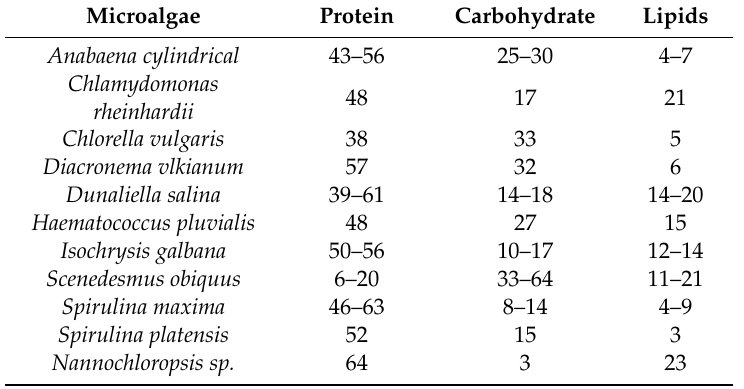
Table 1. Percentage of chemical composition for various microalgae (% dry biomass)